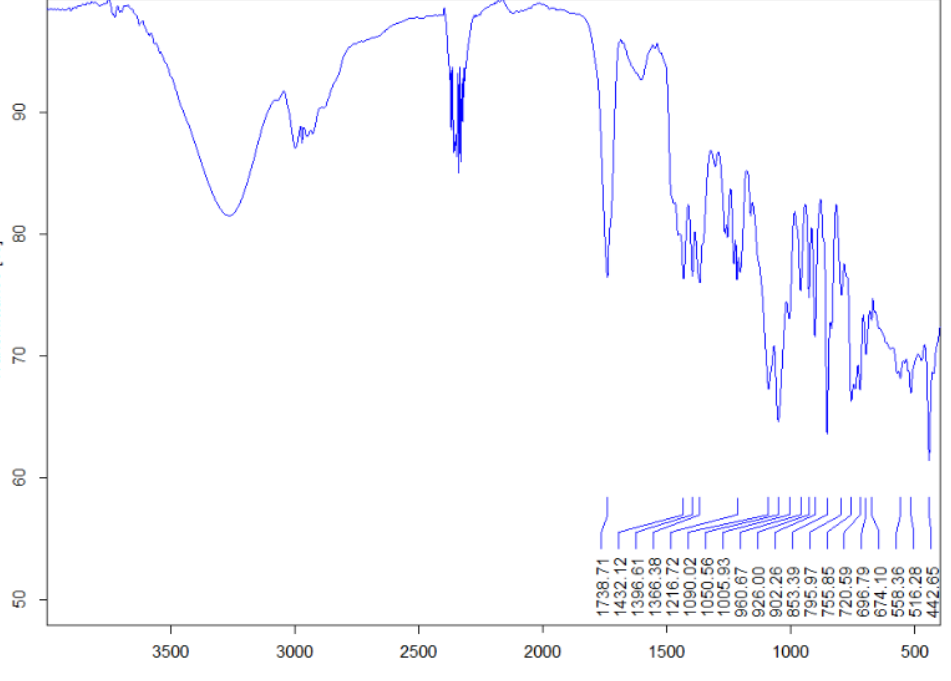
Figure 1. IR spectrum of synthesized TGP.